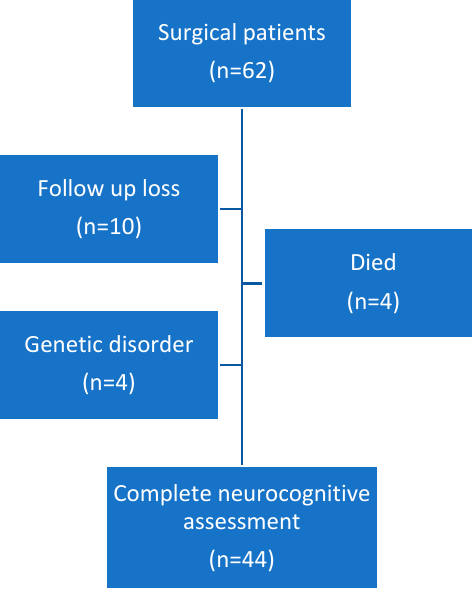
Figure 1. Flow chart of patients. Table 1. Patients’ characteristics (only those with neurological evaluation).